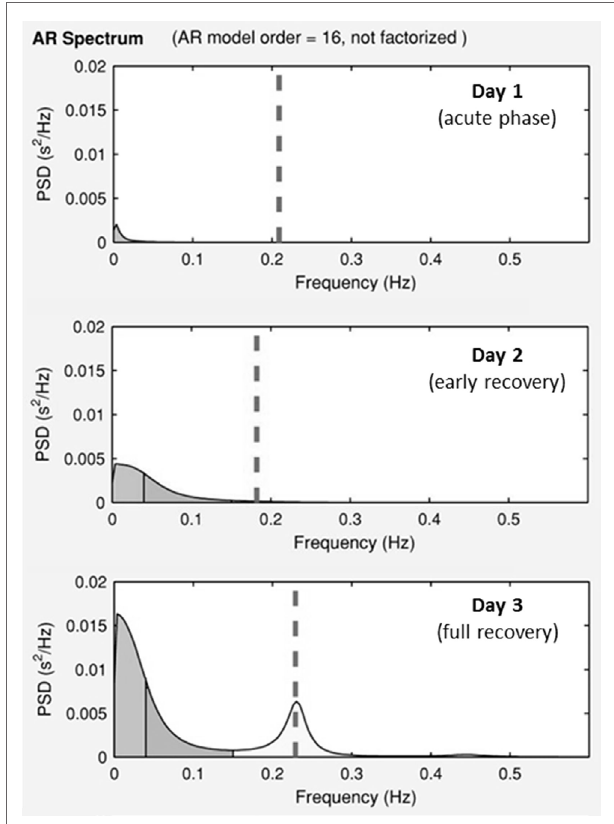
FIgURe 2 | Power spectra of the heart periods during the ICU stay. Day 1, acute phase; Day 2, early recovery; Day 3, full recovery. On the y -axis is the power spectra density (PSD), on the x -axis is the frequency. Dotted lines represent ECG—derived respiratory